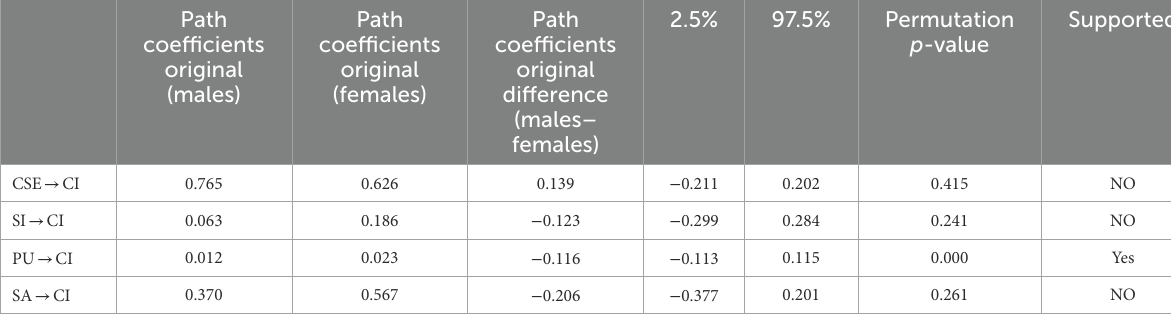
TABLE 14 Assessment of group differences.